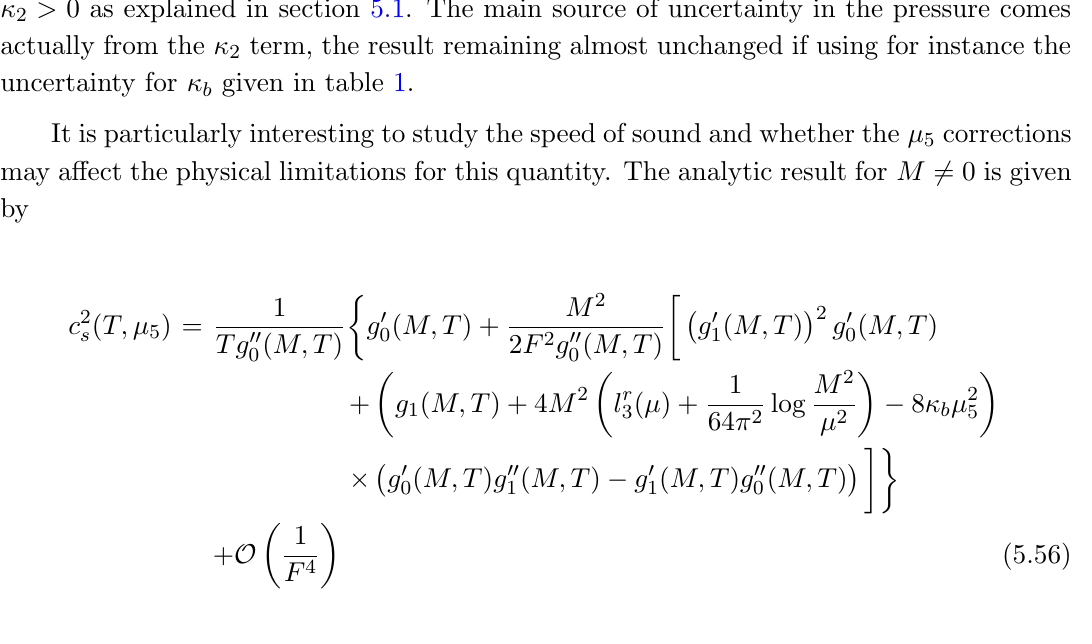
; j (cid:20) b j (cid:20) 1 16 (cid:25) 2 16 (cid:25) 2